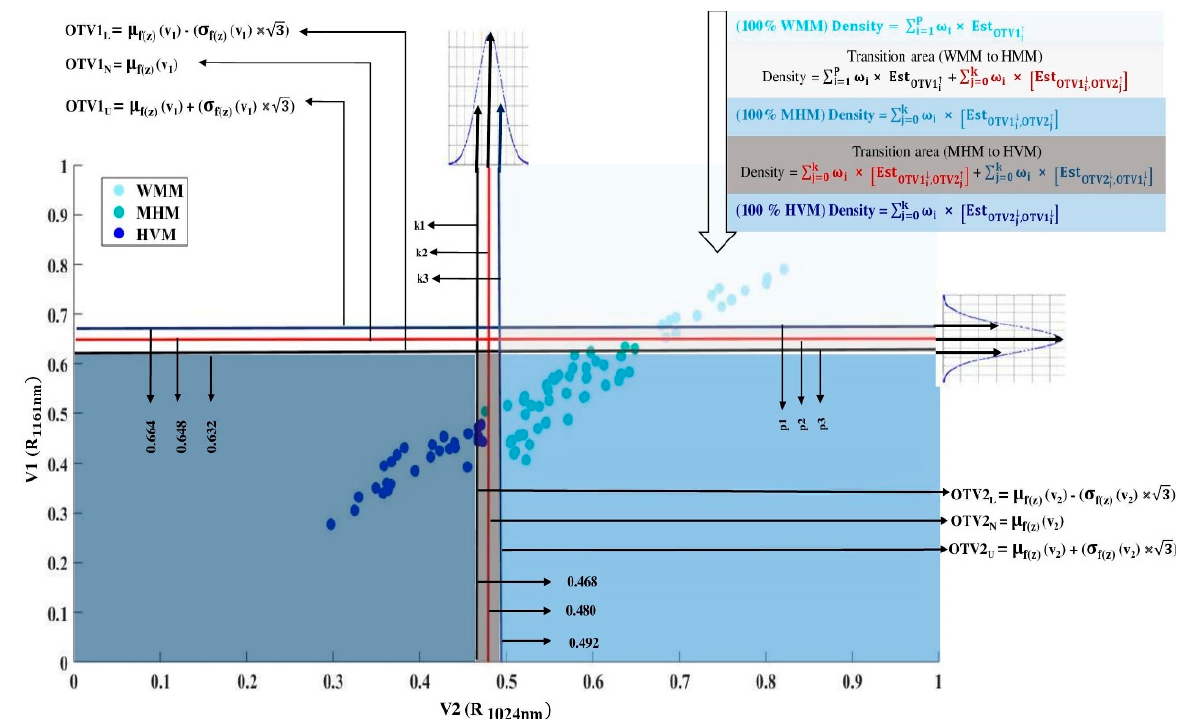
Figure 5. The two-dimensional GQF scheme using variables V1 and V2 and its application to calibrate the EBS. The black, red, and blue lines represent the optimal thresholds (lower, nominal, and upper, respectively) for V1 (OTV1L = 0.632, OT1N = 0.648 and OTV1U = 0.664) and V2 (OTV2L = 0.468, OTV2N = 0.480 and OTV2U = 0.492). k (1–3) and p (1–3) are the indices of the optimal thresholds associated with V1 and V2. The light blue, marine blue, and dark blue points represent the data used for training (WMM, MHM, and HVM, respectively) to calibrate the specific estimators. At the top right is the flow chart of the simplified EBS operational mode. The light blue, marine blue, and dark blue boxes designate the areas with WMM, MHM, and HVM classes, respectively. The overlapping areas in light and dark grey indicate the transitions between low-moderate and moderate-high densities, respectively. The terms of the equations are detailed in Equation (6). A detailed flow chart is presented in Appendix B.